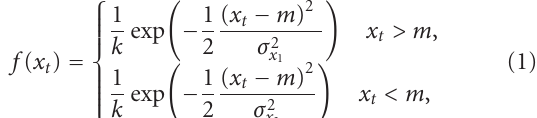
two di ff erent standard deviations is